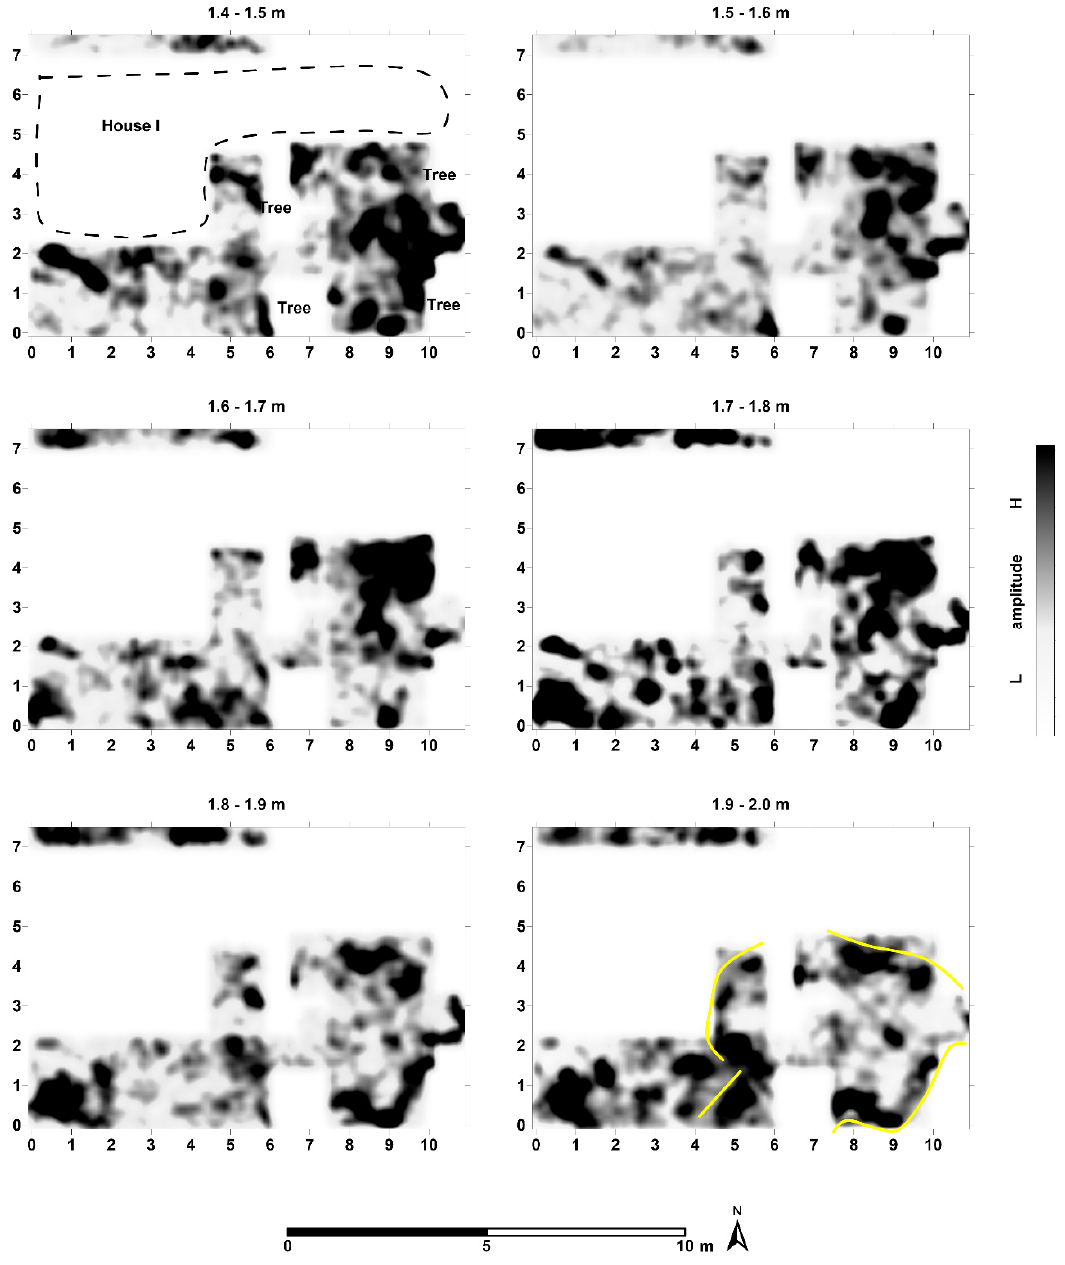
Figure 12. GPR survey area around House I depression. The outline of a deeper house appeared in the GPR survey from a depth of 1.4–2.0 m, shown above as a series of depth-slices at 0.1 m increments. The projected perimeter of the deeper house is indicated in yellow in the final slice. GPR coverage was limited by the presence of trees at this forested site.